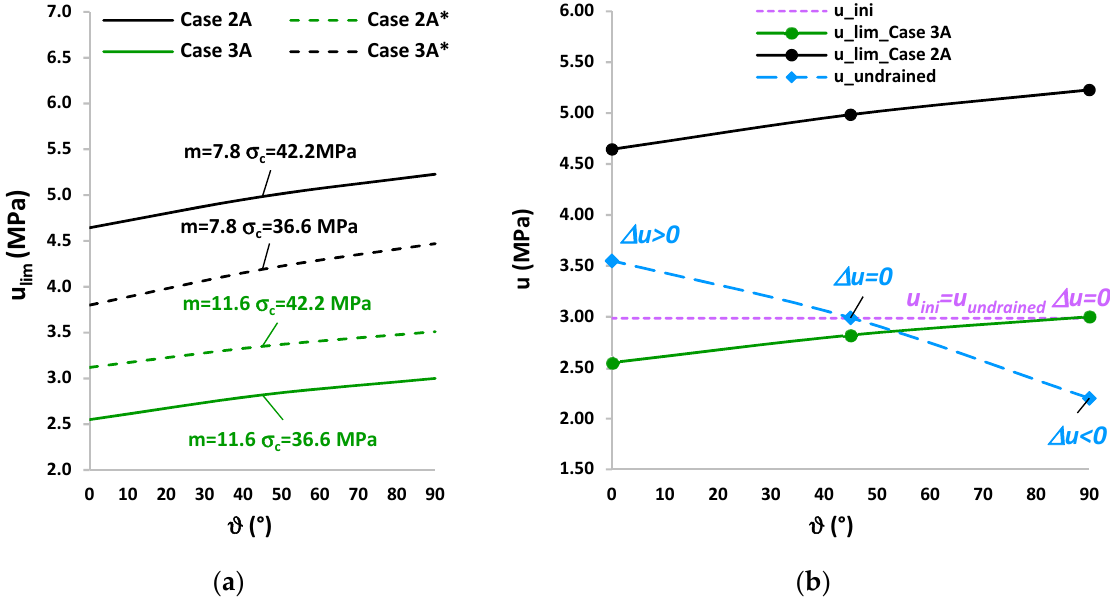
Figure 7. ( a ) Variation of u lim with ϑ in all the Cases reported in Table 3; ( b ) Variation of u lim with ϑ in Case 2A and Case 3A at r = R . Comparison with the initial pore pressure u ini and the pore pressure in undrained condition Δ u = 0 and Δ u ≠ 0 (calculated with FLAC in Case 3A).